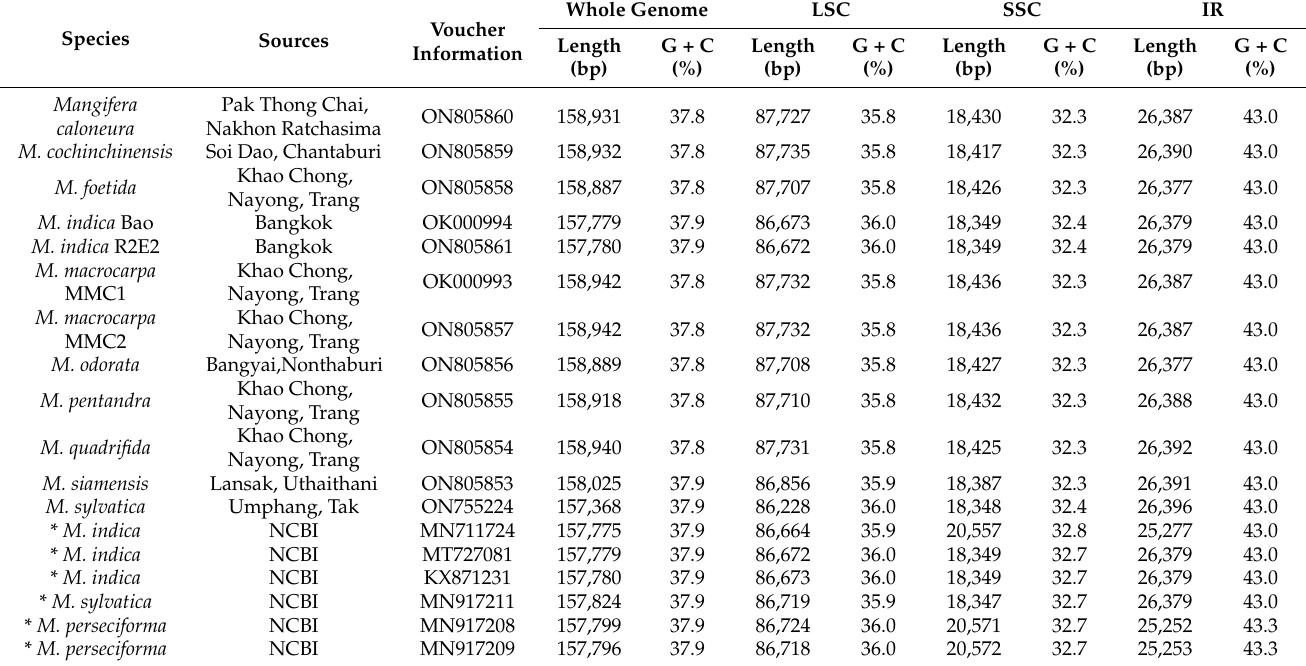
Table 1. The chloroplast genome characteristics of Mangifera